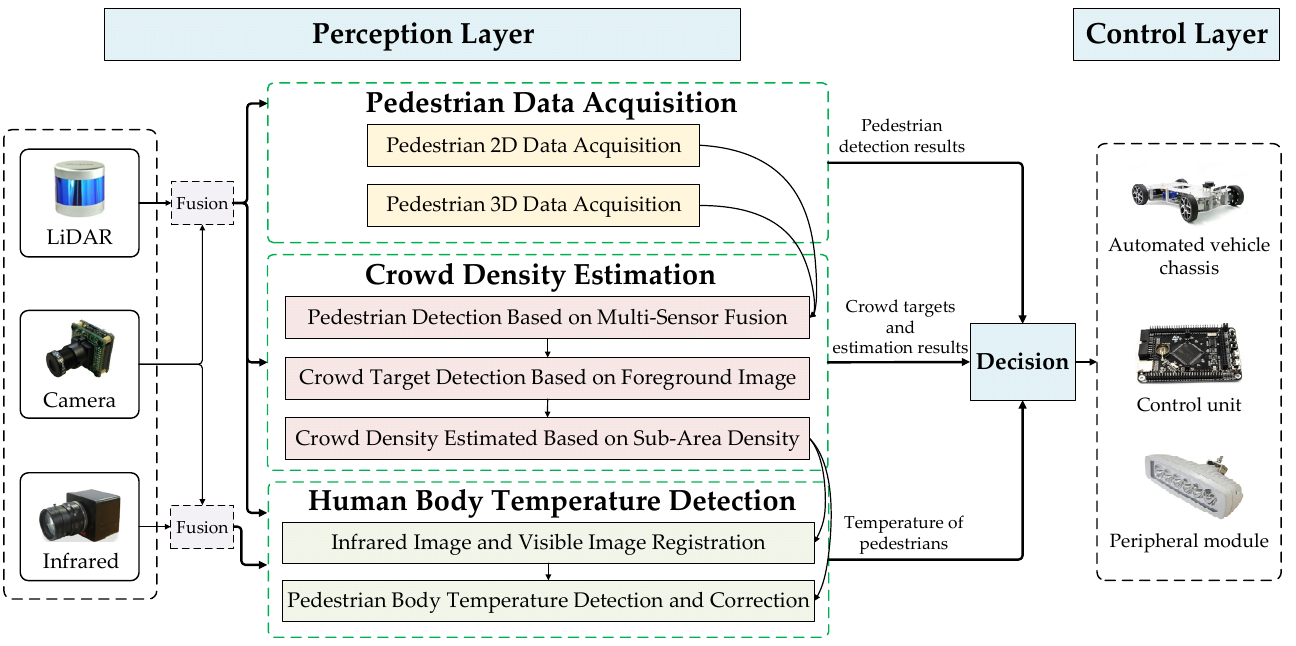
Figure 1. Structure of advanced pedestrian state sensing method for automated patrol vehicle based on multi-sensor